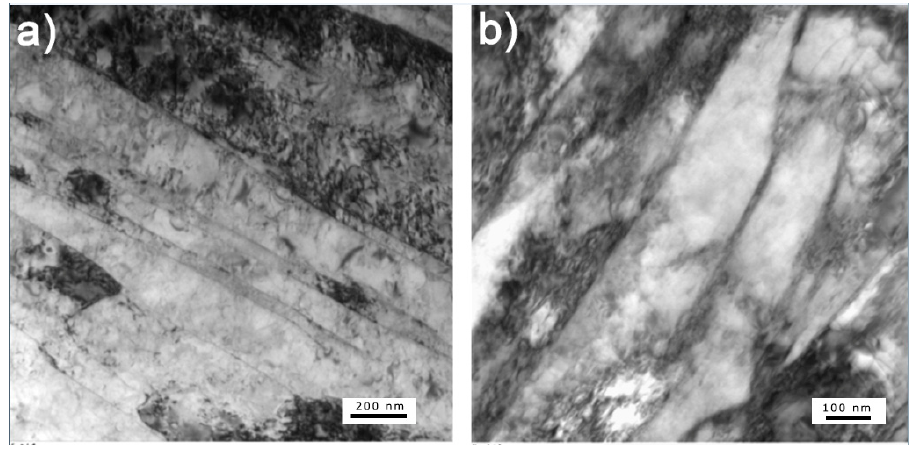
Figure 4. TEM electron micrographs of ( a ) Heat A and ( b ) Heat B after oil quenching (OQ samples).